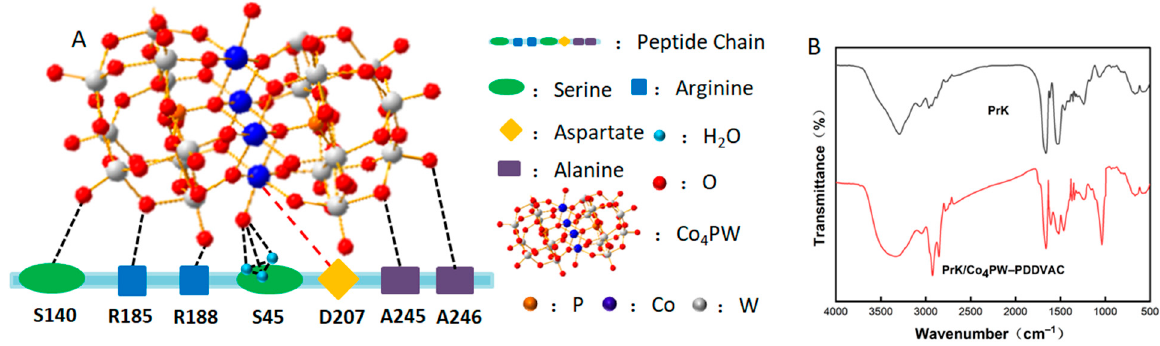
Figure 4. ( A ) Schematic illustration of the interactions between Co 4 PW–PDDVAC composite and PrK peptide chains. ( B ) FTIR spectra of PrK and PrK/Co 4 PW–PDDVAC. peptide chains. ( B ) FTIR spectra of PrK and PrK/Co 4